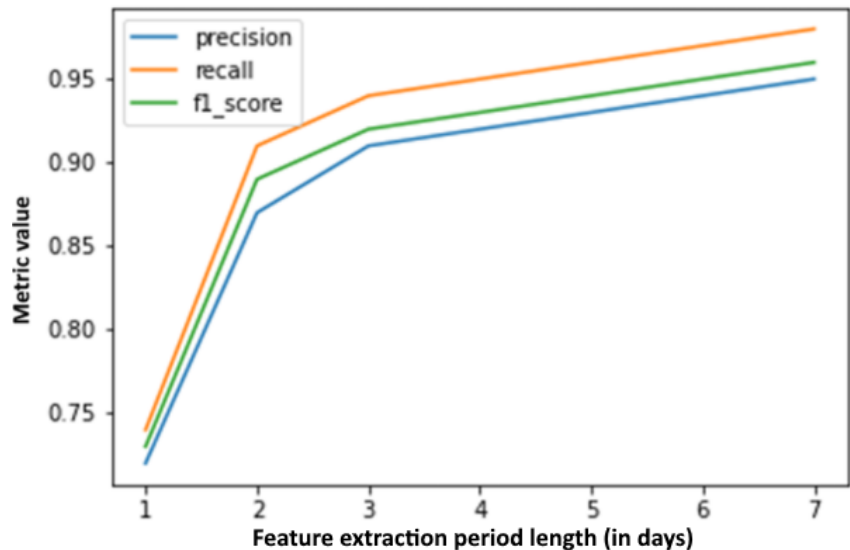
Figure 10. Metric changes by feature extraction period duration.